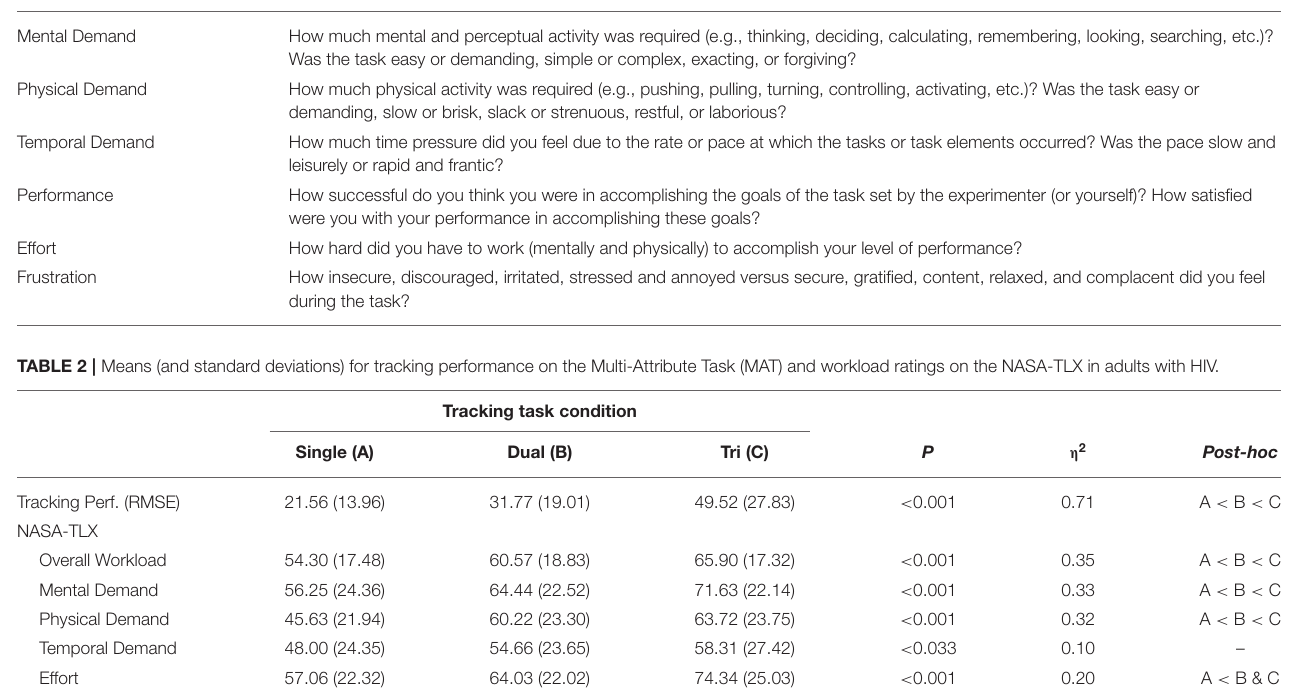
TABLE 1 | NASA-Task Load Index rating subscale descriptions. Subscale title